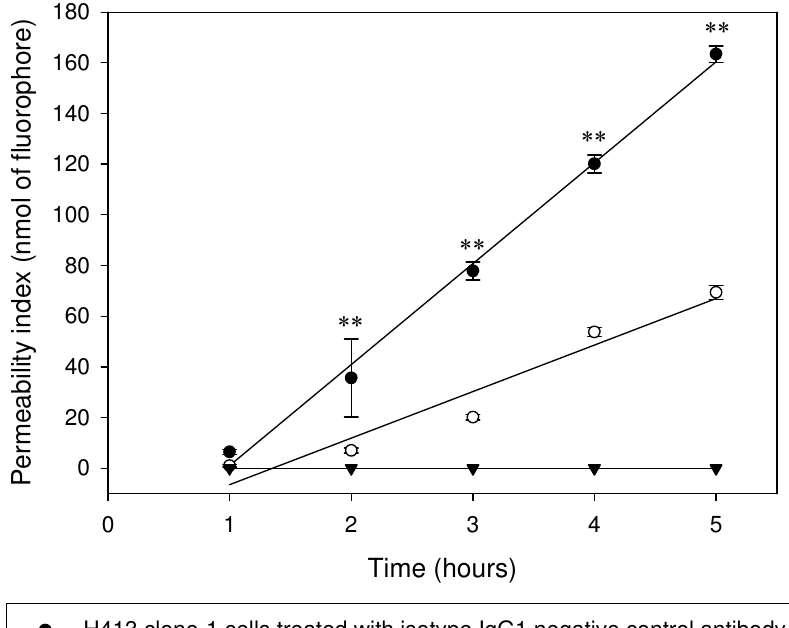
H413 clone-1 cells treated with isotype IgG1 negative control antibody and permeability to dextran Alexa Fluor 647 (10 kDa) measured Cells treated with CD24 peptide antibody and permeability to dextran Alexa Fluor 647 (10 kDa)